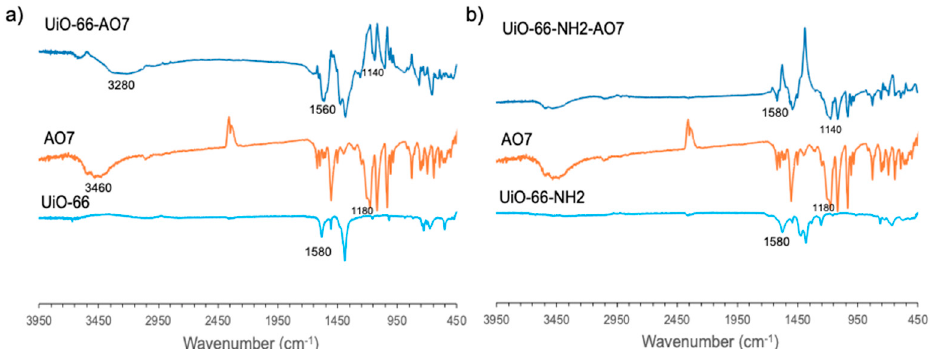
Figure 2. IR of ( a ) UiO-66 and ( b ) UiO-66-NH 2 before and after dye adsorption.